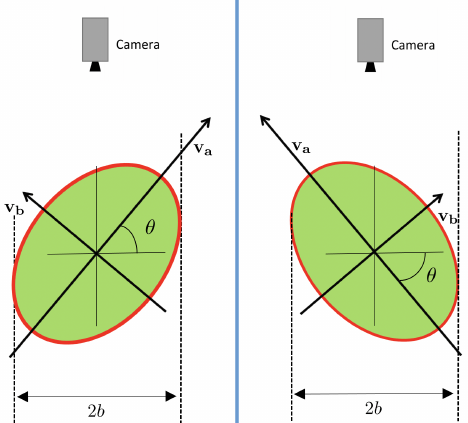
Figure 12. Ambiguity in the estimation of the elevation angle. The perceived shape from the camera is the same in both